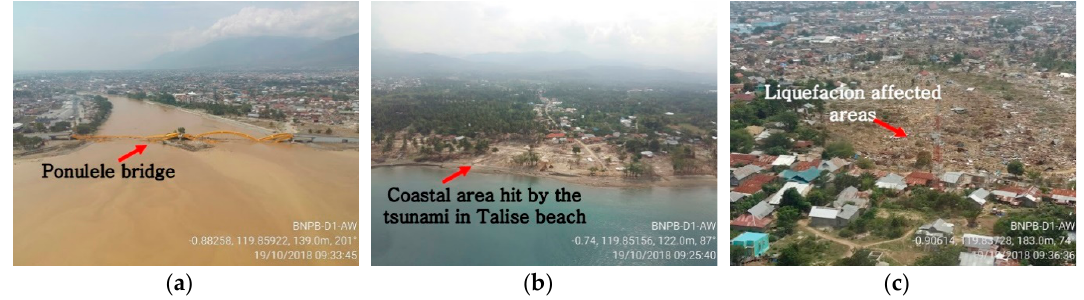
Figure 3. Photographs of the conditions after the Mw 7.4 earthquake in Palu, Indonesia: ( a ) collapse of the iconic Ponulele Bridge; ( b ) tsunami damage in the coastal area; and ( c ) liquefaction within an area of Palu. Modified from [39].